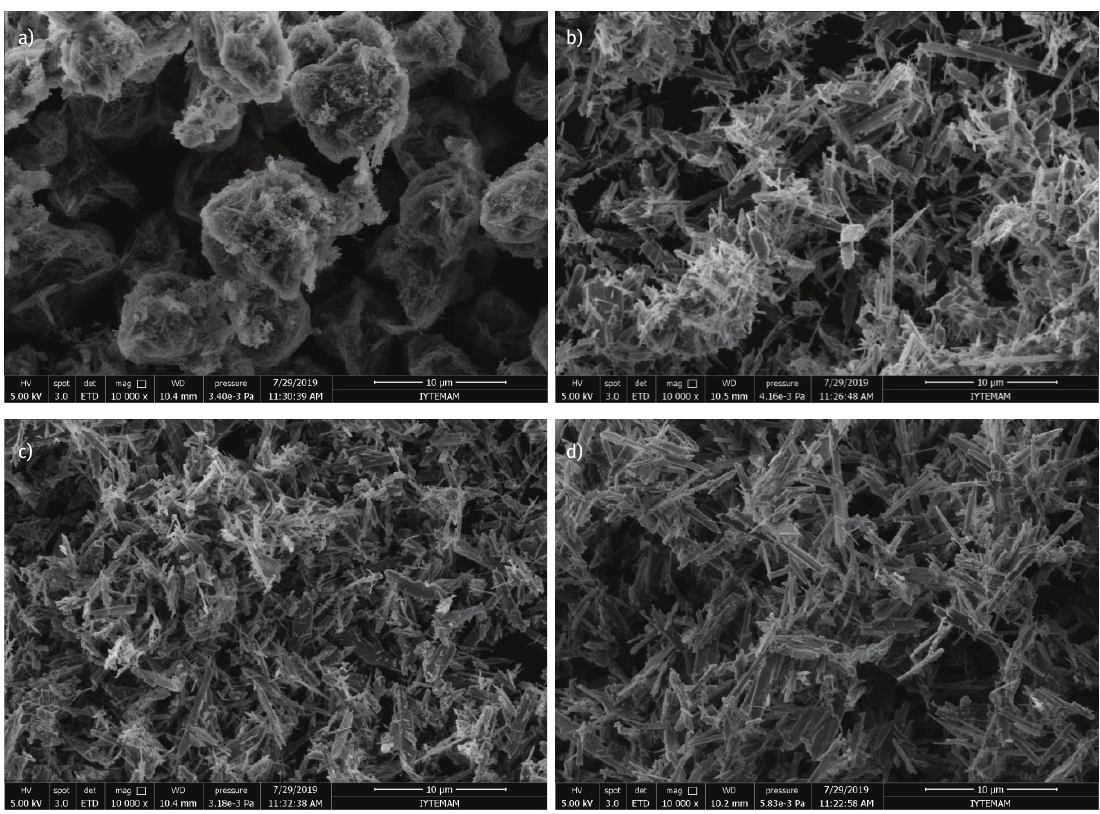
Figure 4: SEM microphotographs of solid products obtained at 110°C for: (a) 4 h, (b) 5 h, (c) 6 h, and (d) at 120°C for 5